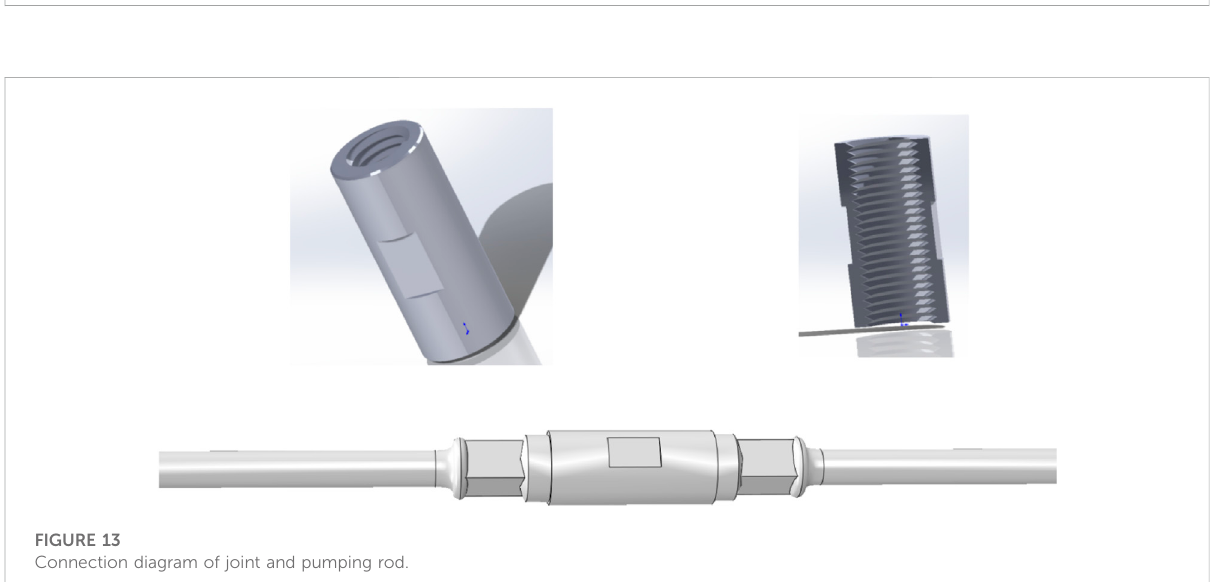
FIGURE 12 Stress variation curves at different locations within one stroke of the pumping rod.